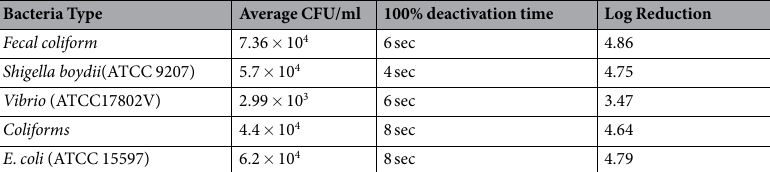
Table 1. Summary of the five types of Bacteria deactivation.